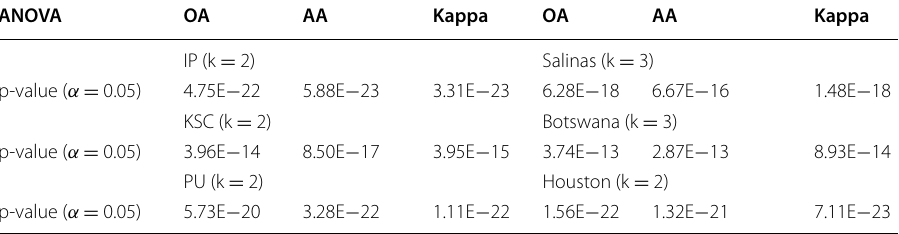
Table 10 Detailed ANOVA Single Factor p-value results between all semantic segmentation methods as shown in Table 5. With the accepted α 0.05, all p-values are well under the alpha, and = therefore the tests are statistically significant ANOVA OA AA Kappa OA AA Kappa IP (k 2) Salinas (k 3) = = p-value ( α 0.05) 8.58E 27 2.07E 26 9.12E 28 7.51E 14 8.78E 09 1.39E = − − − − − KSC (k 2) Botswana (k 3) = = p-value ( α 0.05) 1.41E 11 = − PU (k 2) Houston (k 2) = = p-value ( α 0.05) =